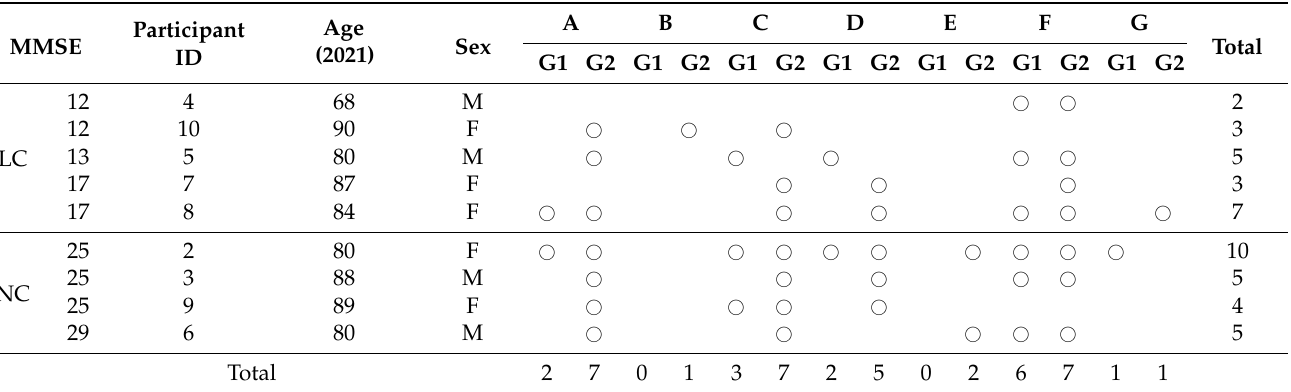
Table 1. Individual sight